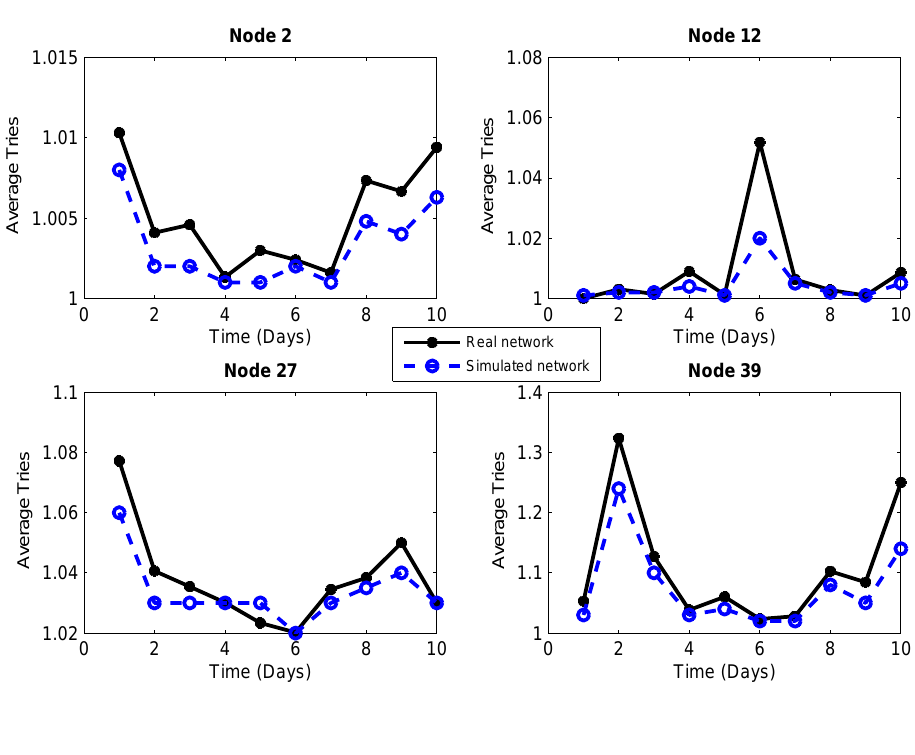
Figure 9. Average number of tries per day in relay